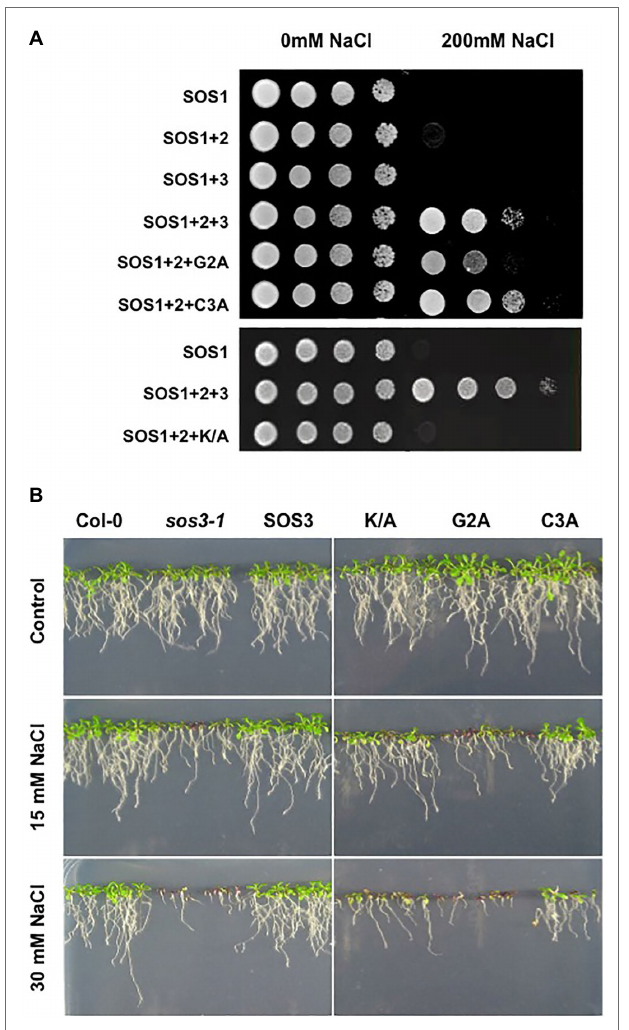
FIGURE 3 | Functionality of the SOS pathway. (A) Reconstitution of the SOS pathway in yeast. YP890 cells expressing the indicated combination of Arabidopsis SOS1, SOS2, and SOS3 proteins were grown overnight in liquid AP medium with 1 mM KCl. Five microliters of serial decimal dilutions were spotted onto plates of the same medium or supplemented with 200 mM NaCl. Plates were incubated at 28 ° C and photographed after 4 days. G2A, C3A and K/A denote the corresponding SOS3 mutants. (B) Ten-day old seedlings of homozygous transgenic lines of the sos3-1 mutant of Arabidopsis transformed to express the wild-type SOS3 protein (SOS3) or the K/A, G2A, and C3A mutants grown in MS plates were transferred to LAK medium with 1 mM KCl and supplemented or not with 15 mM and 30 mM NaCl. Col-0 and the sos3-1 mutant were used as control. Plates were incubated vertically for 12–14 days at 25 ° C with a 16 h/8 h light